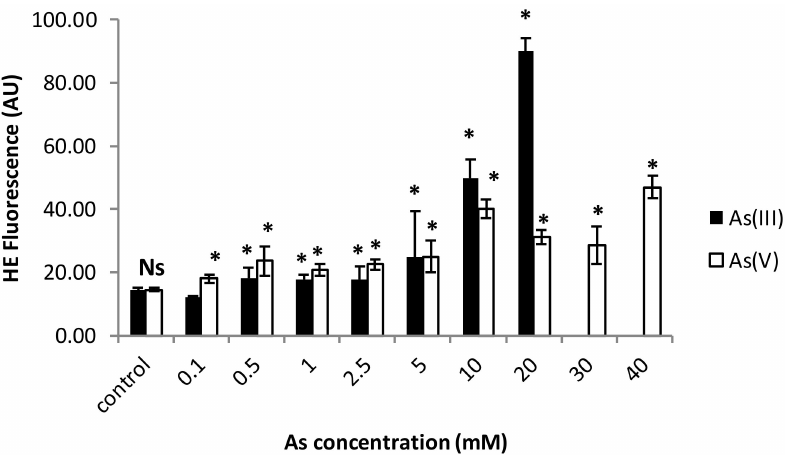
Figure 2. Increase of hidroethidine fluorescence in cultures exposed to di ff erent arsenite (As(III)) or arsenate (As(V)) treatments. * (asterisks) indicate significant di ff erences from control ( p < 0.001). Ns—